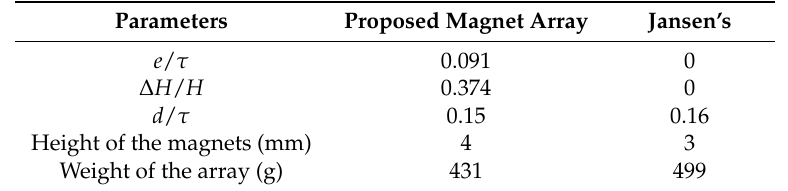
Table 3. Parameters for the proposed magnet array and Jansen’s.